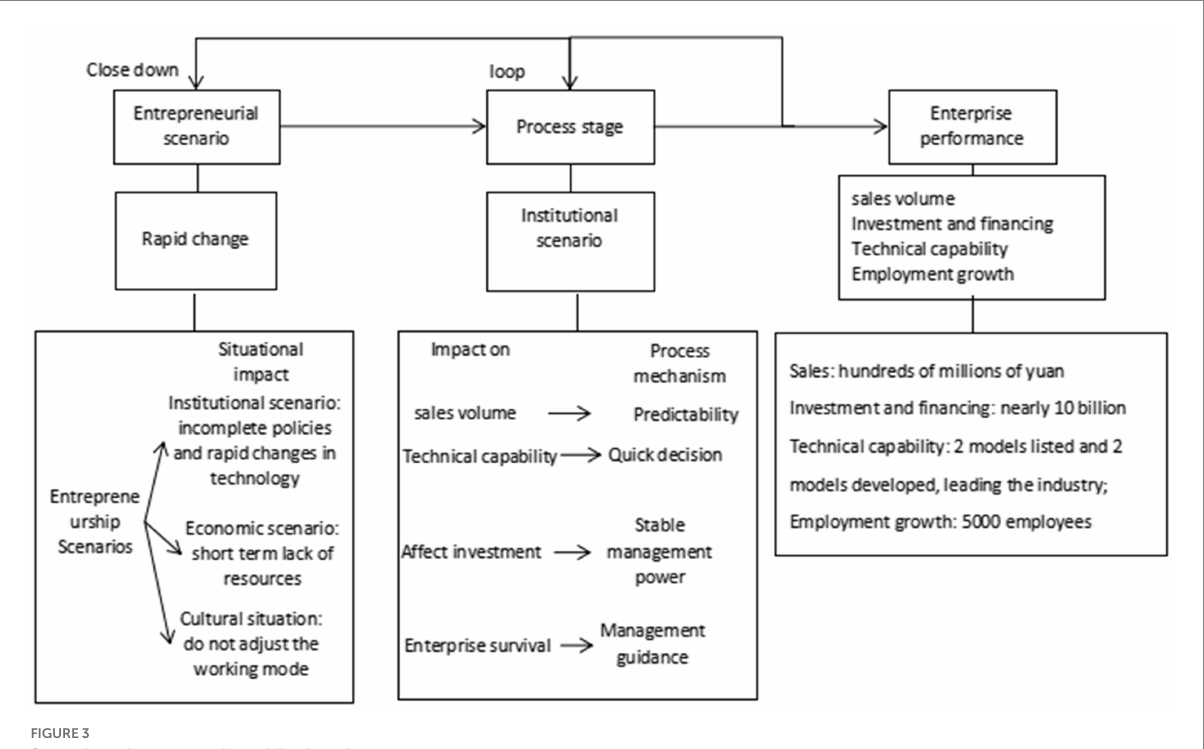
FIGURE 3 Scenario action process in rapidly changing